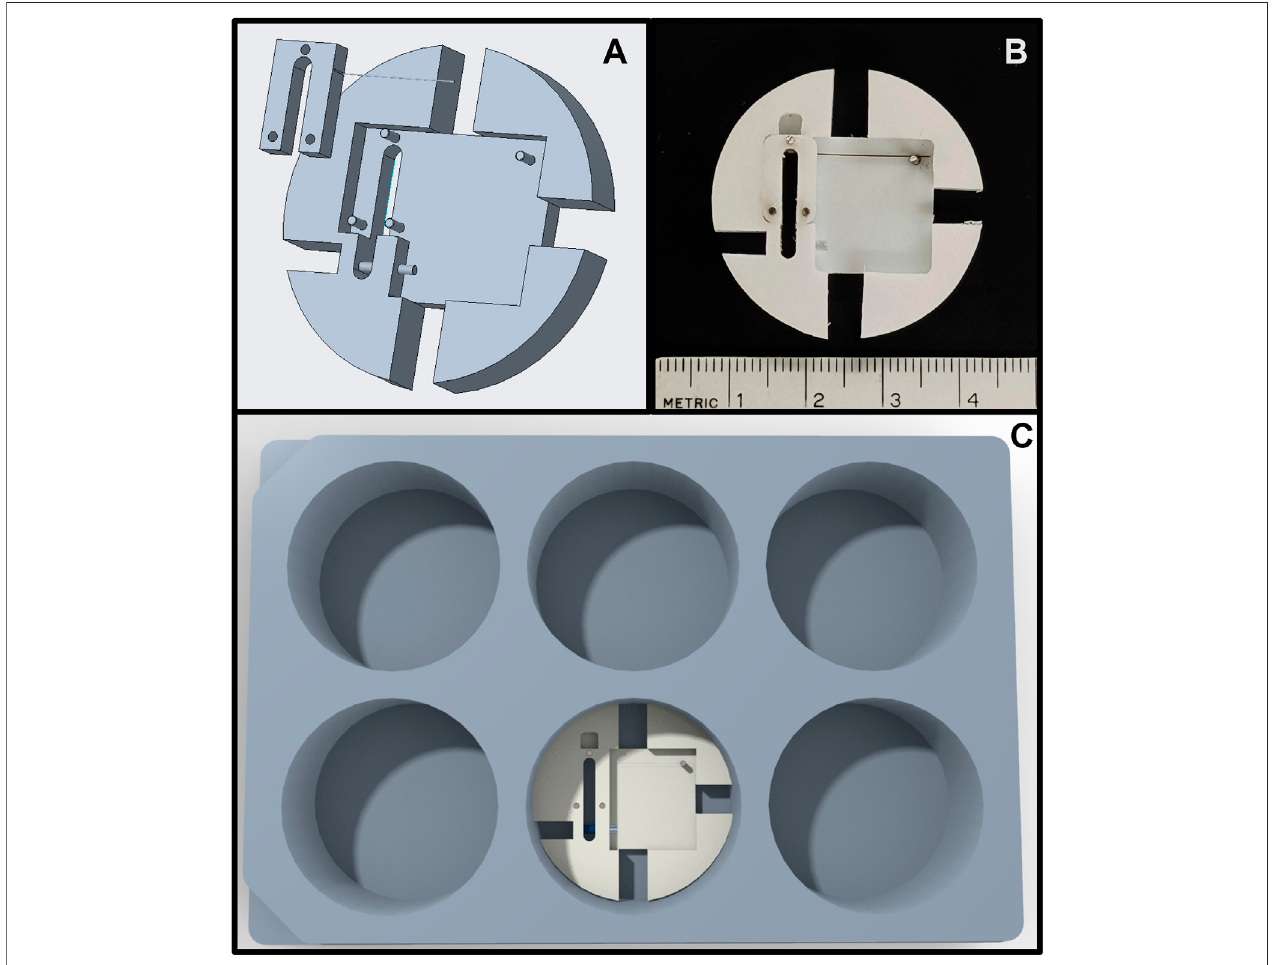
FIGURE8|(A) Renderingofthescaled-downforce-bioreactor. (B) Imageofaprototypebioreactor. (C) Renderingofthescaled-downbioreactorinsideastandard 6-well tissue culture plate.